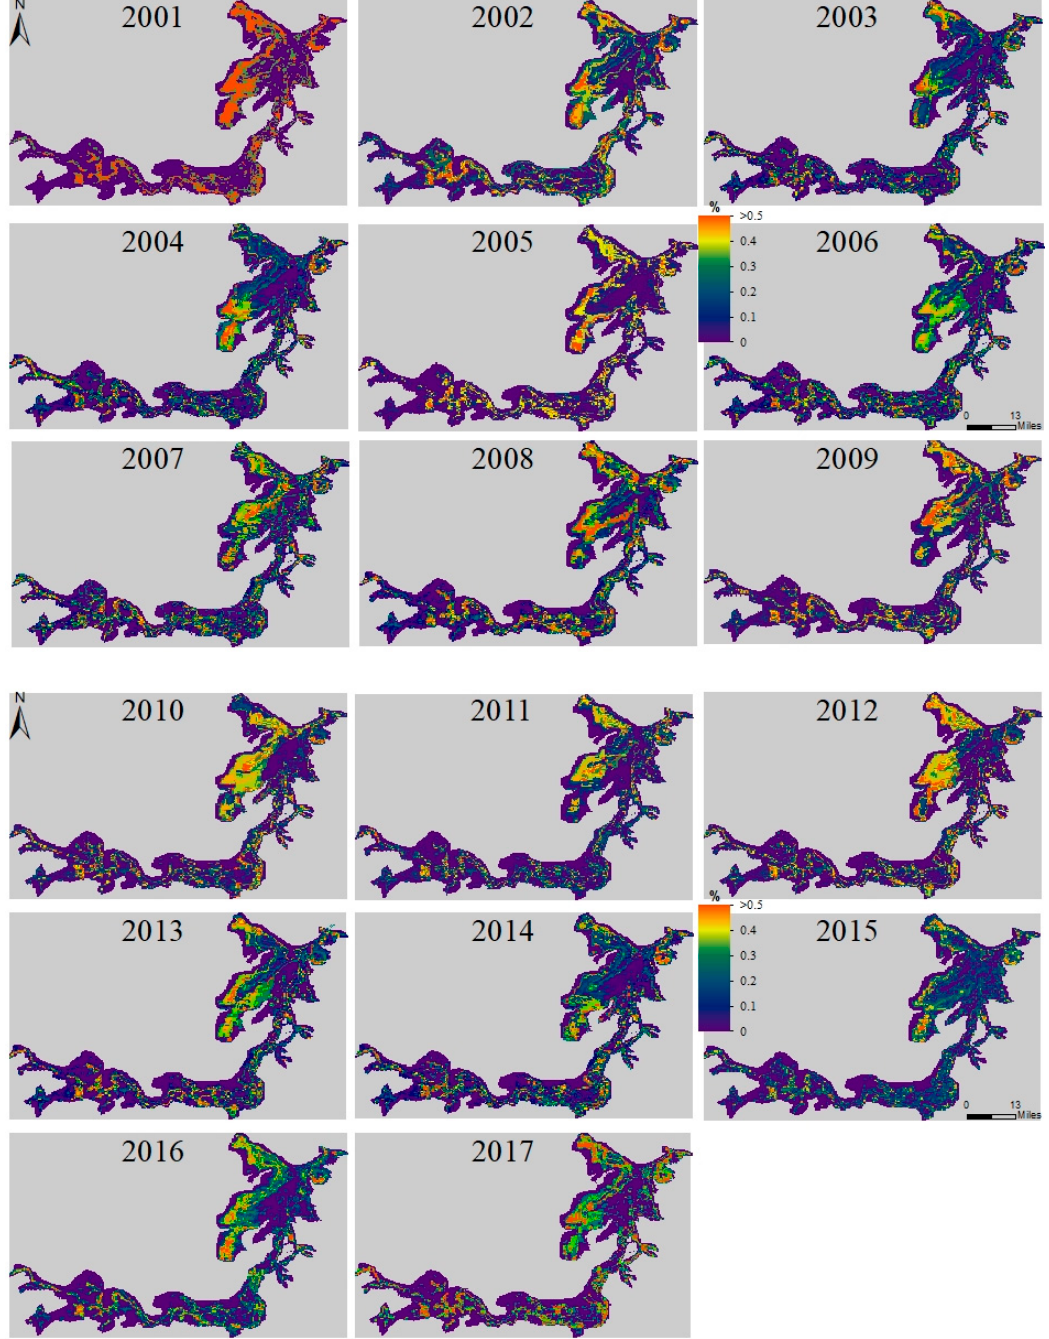
Figure 10. Frequencies of blooms in different areas of Dongting Lake from 2001 to 2017.